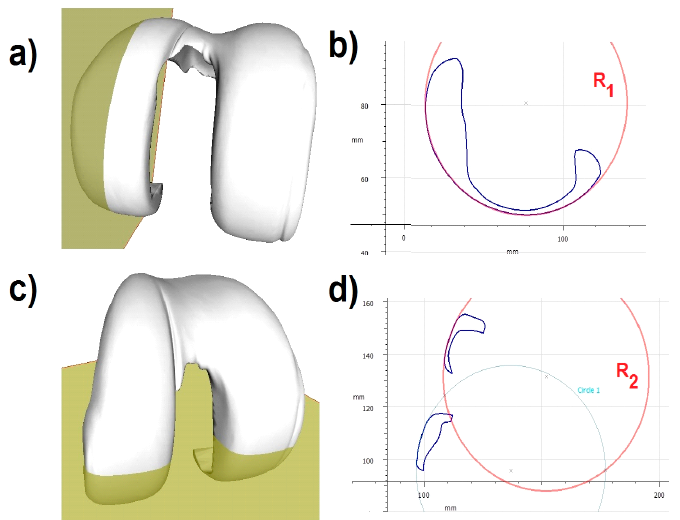
Figure 3. Digital cross-sections of a femoral knee implant, the definition of radii in sagittal ( a,b ) and transverse planes ( c,d ) for right kinematics of the adjacent part of the joint–the UHMWPE insert.